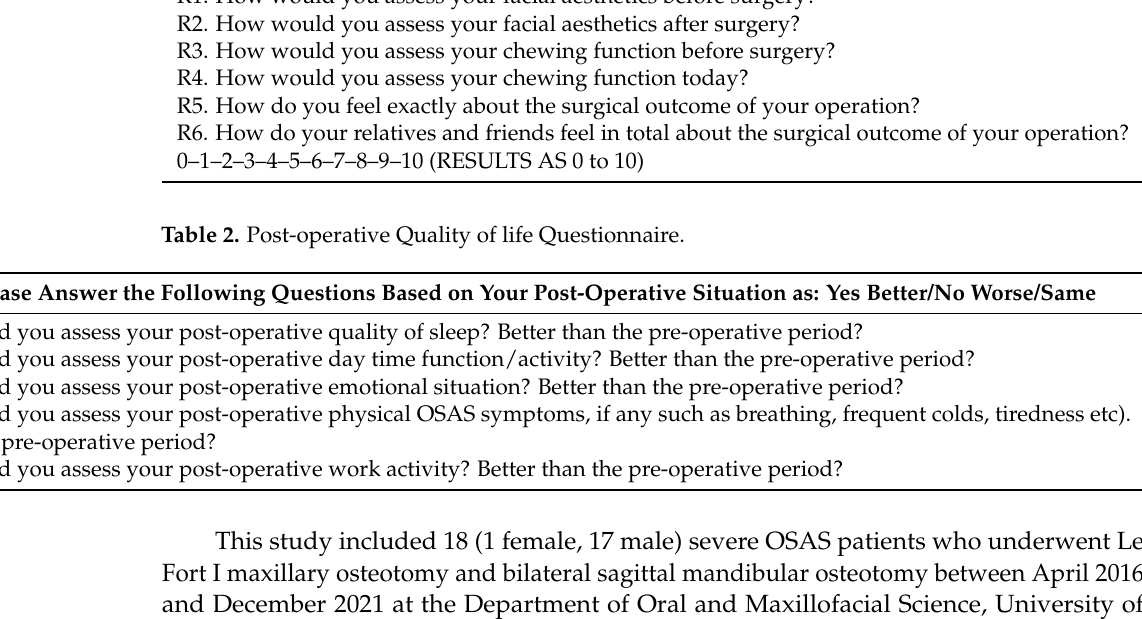
Table 1. Rustemeyer’s questionnaire about patients’ satisfaction after surgery. Questions: Please Mark One Grade of the Scale from 0 (Poor) to 10 (Excellent)